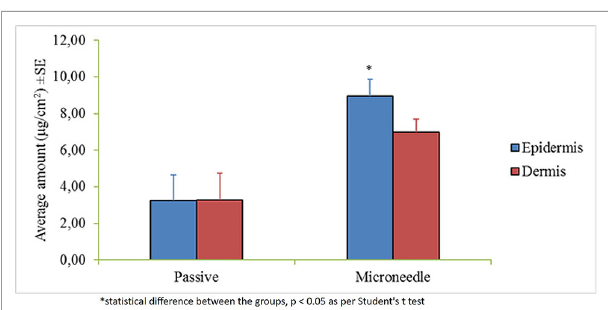
FIGURE 3 | Average amount of myrsinoside B retained in the epiderms and dermis of the human dermatomed skin (µg/cm 2 + SE). The epidermis of the maltose microneedle treated group retained signi fi cantly greater amounts of myrsinoside B compared to the epidermis of the passive delivery group, however, no statistical difference was observed for the dermis (n ≥ 3, Student ’ s t-test p < 0.05 indicates signi fi cant difference).